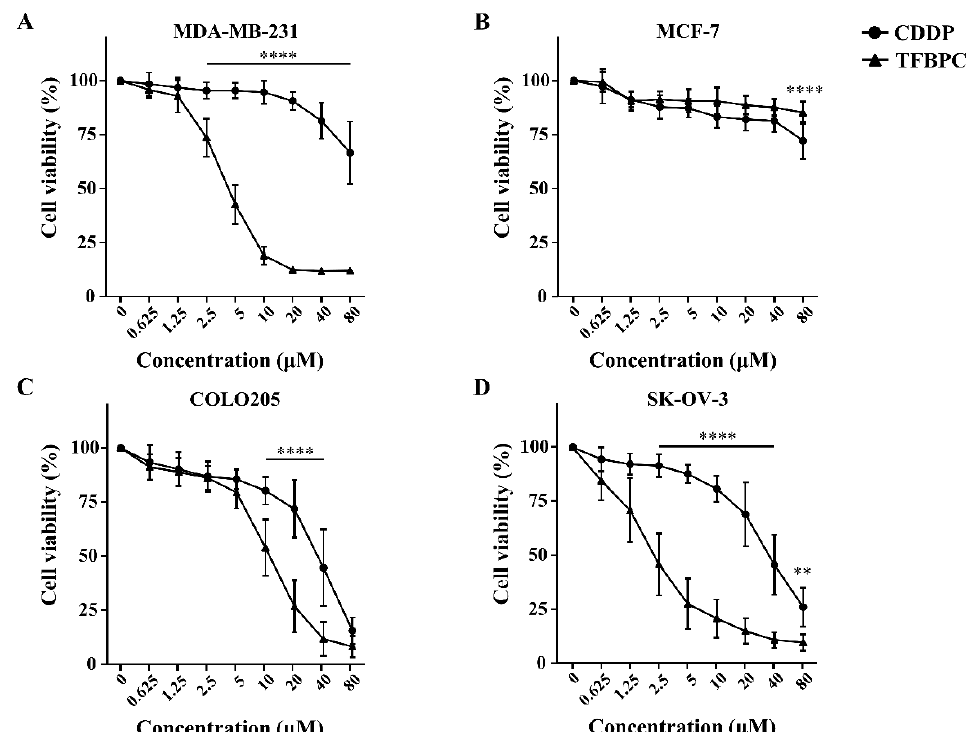
Figure 2. TFBPC inhibited the growth of human cancer cells in a dose-dependent effect. The cyto- toxic effects of TFBPC and CDDP on MDA-MB-231 breast cancer cells ( A ), MCF-7 breast cancer cells ( B ), COLO205 colon cancer cells ( C ) and SK-OV-3 ovarian cancer cells ( D ) were determined using